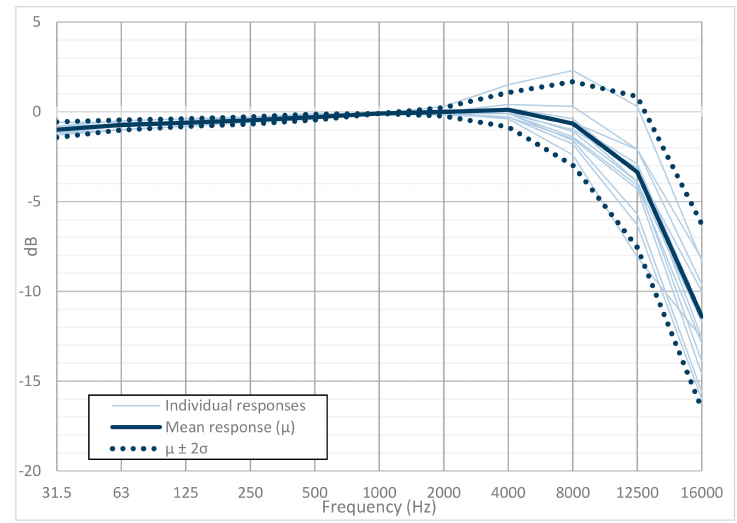
Figure 9. Di ff erence in the average value between the type I reference equipment and the mean of the measures of the equipment designed for each frequency band.